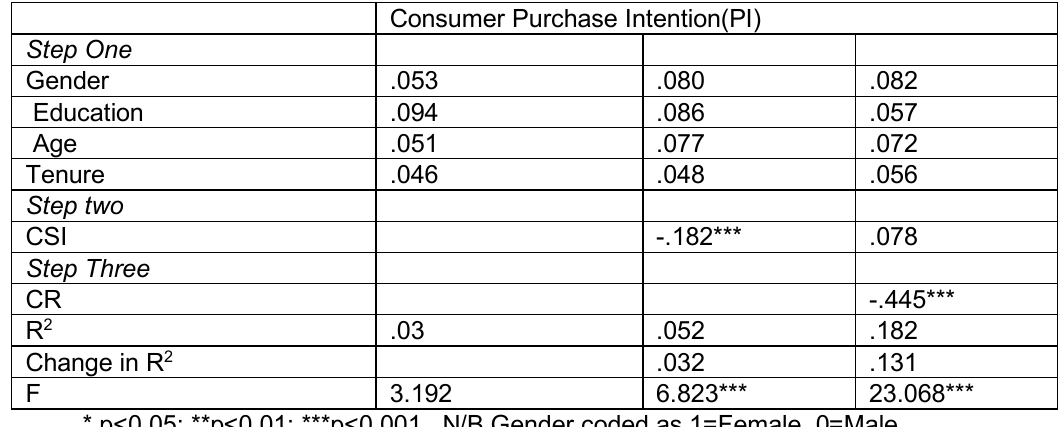
Table 5: Mediation effect of CR in the relationship between CSI and PI Consumer Purchase Intention(PI)